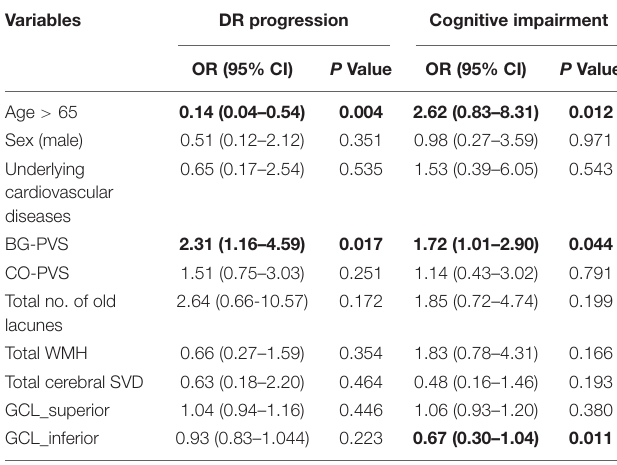
TABLE 3 | Multivariable logistic regression models for the determination of significant cerebro-ophthalmic parameters for DR progression (proliferative stage) and for cognitive impairment (adjusted MMSE score <